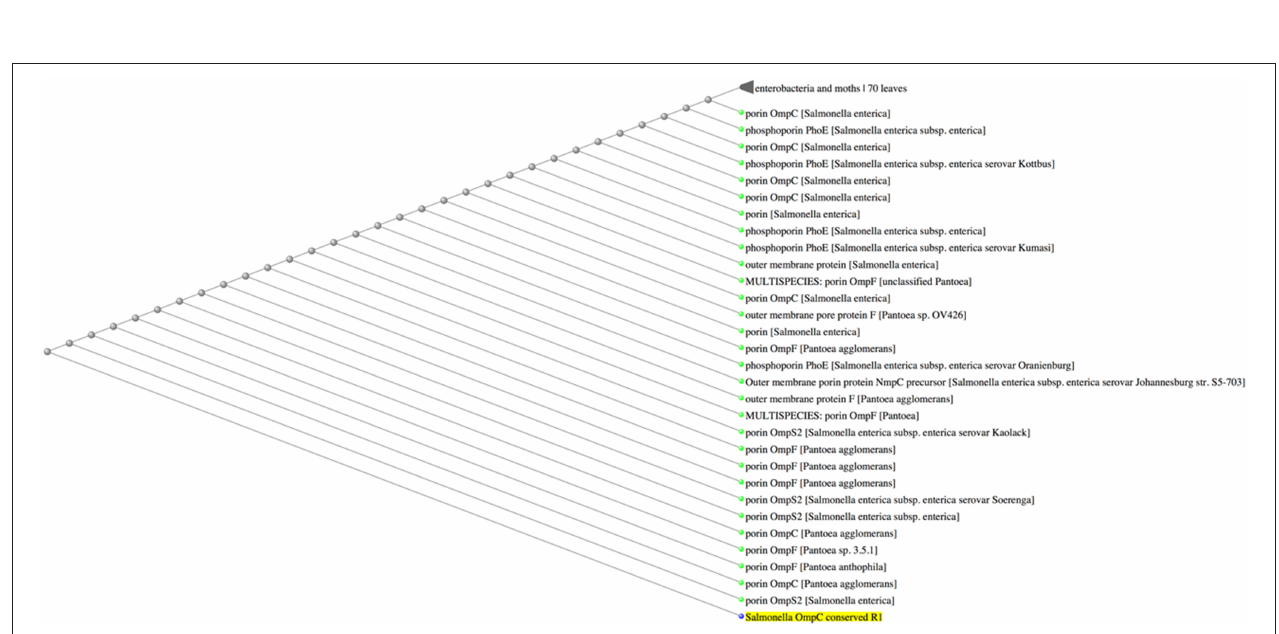
FIGURE 4 | The amino acid sequence of R1 is exclusive of Salmonella porins. Fast minimum evolution tree between the R1 sequence and the Non-Redundant (nr) GenBank database calculated by BLASTp.